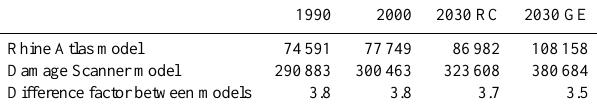
Table 3. Absolute damage estimates of the model-run RAM DSM and difference factors between the RAM and the RAM DSM , and between the DSM and the RAM DSM